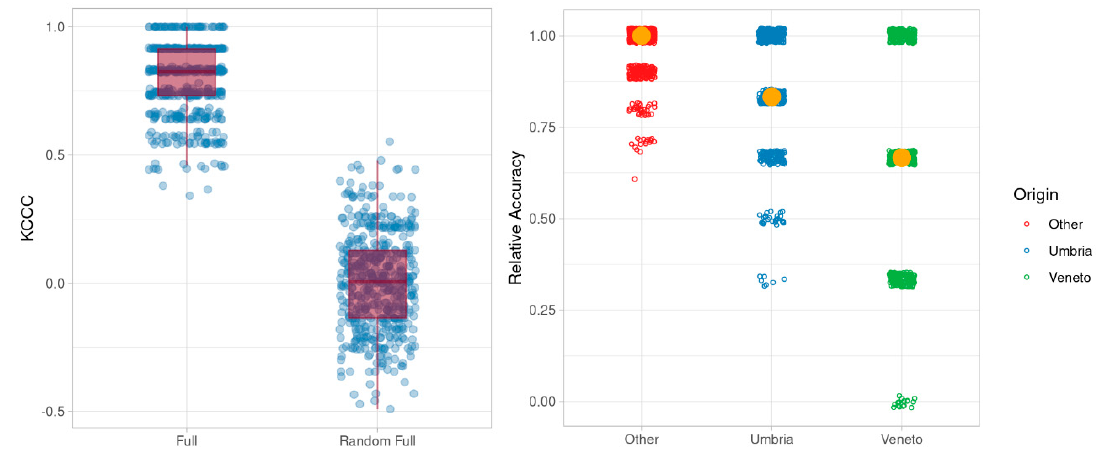
Figure 3. Ability of the developed model to classify origin correctly. Metabolites 2021 , 11 , x FOR PEER REVIEW